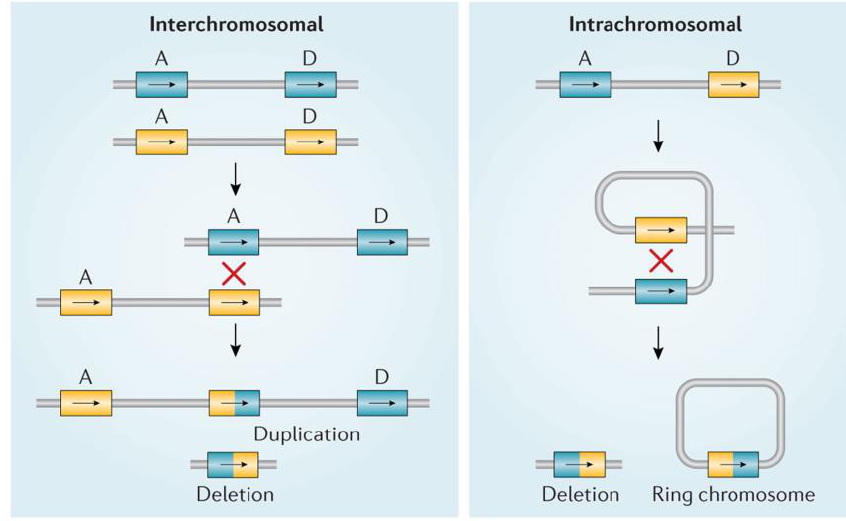
Figure 1. 22q11.2 non-allelic homologous recombination [1]. Diagram of two different types of meiotic non-allelic homologous recombination events that can occur between low copy repeats on chromosome 22 (LCR22s), at spermatogenesis or oogenesis. Rearrangements between LCR22A and LCR22D are indicated (A and D) on each allele (blue versus yellow). Interchromosomal events ( left ) occur between paralogous LCR22s (A and D) in two different alleles owing to >99% sequence identity of direct repeats (“X” shows the crossover of the two chromosomes). The hybrid LCR22 is shown as half yellow and half blue. This process results in a duplication or deletion of the intervening region and genes in resulting gametes. Intrachromosomal recombination events ( right ) result from crossing over (indicated by red “X”) within one allele, resulting in a deletion ( left ) or a ring chromosome ( right ); the ring chromosome is not viable [1].